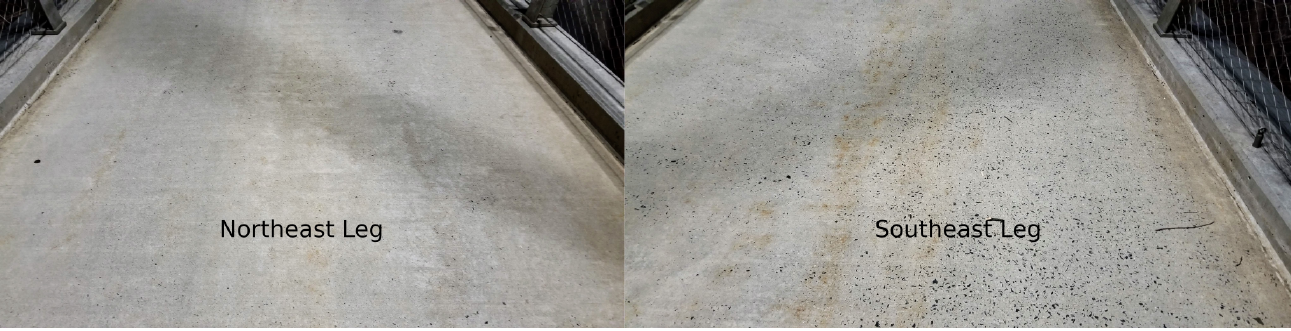
Figure 13. Figure showing increased loss of cover on the southeast leg compared to northeast